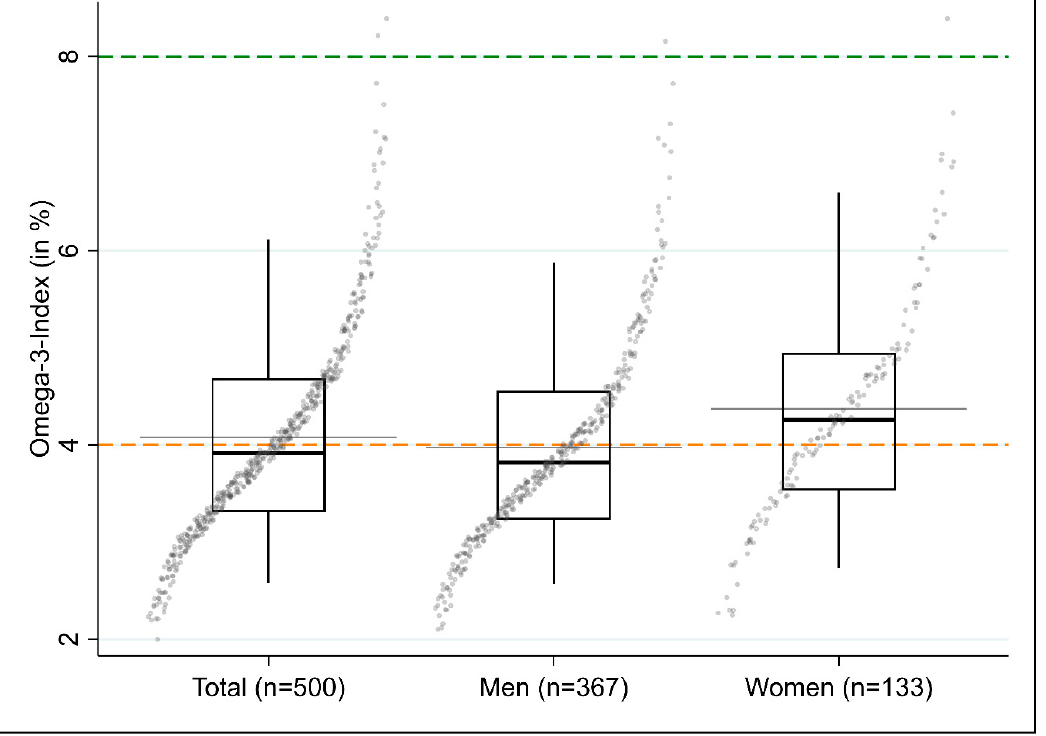
Figure 3. Box quantile plot of the distribution of the omega-3 index (in %) for all participants at baseline ( n = 500) and stratified by gender. The gray horizontal line shows the arithmetic mean, and the bold, black horizontal line inside the box shows the median. The bottom and top of the box are the bottom and top quartiles of the distribution. The length of the black, vertical “whiskers” corresponds to the 5th and 95th percentile of the variable. The quantile plot plots the ordered values of the respective variables (ordinate) against the cumulative probability (abscissa). The dashed horizontal lines each show the borders between the levels of cardioprotection, largest to average (green, 8%) and average to least (orange, 4%). For illustrative purposes, horizonal dispersion (jitter) was added to the individual datapoints.